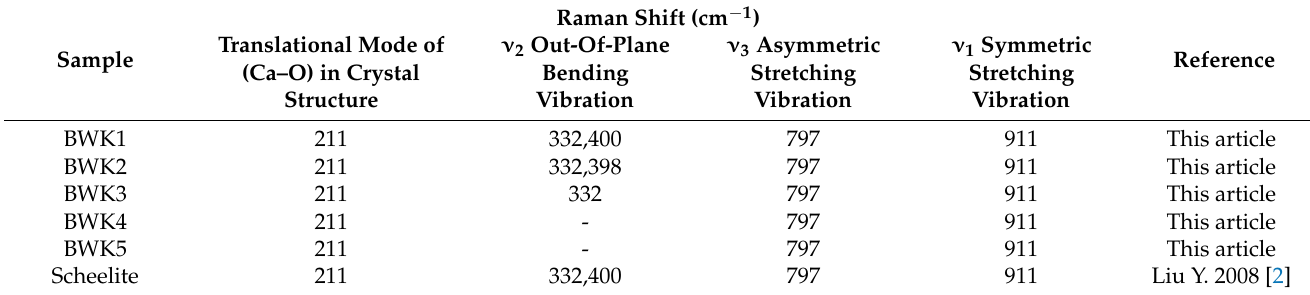
Table 2. Raman analysis of scheelite samples BWK1 − 5.